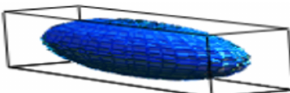
Figure 6. A mine modeled as an